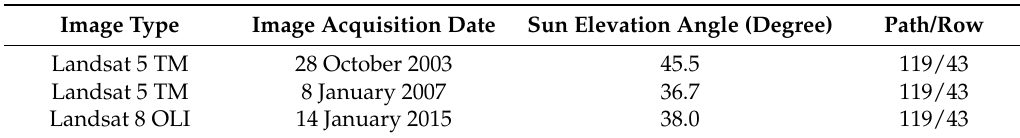
Table 1. Characteristics of Landsat images used in the study.